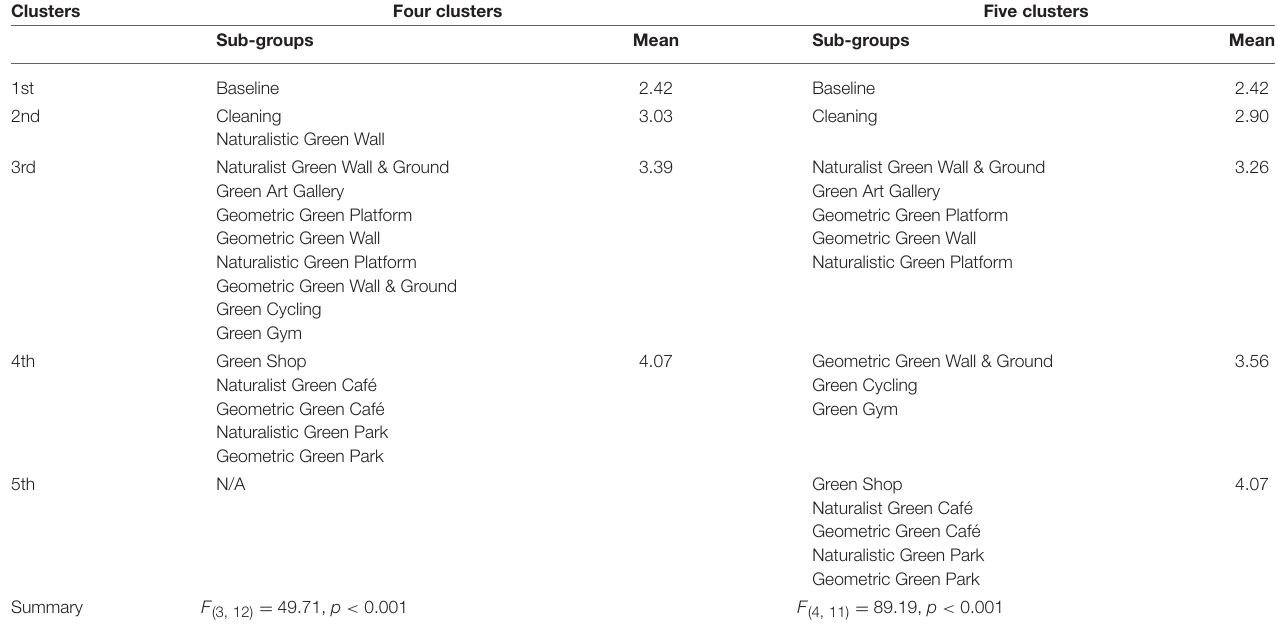
TABLE 5 | Statistical clustering of 16 scenes: results of the four and five K-means cluster analysis.